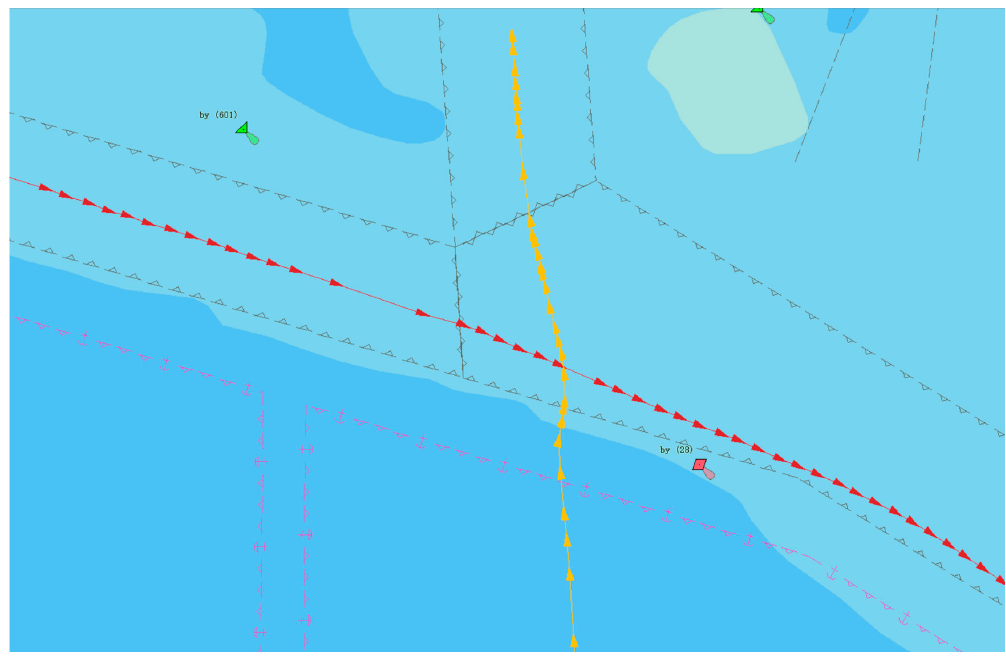
Figure 19. Double GRU-RNN training data preparation.